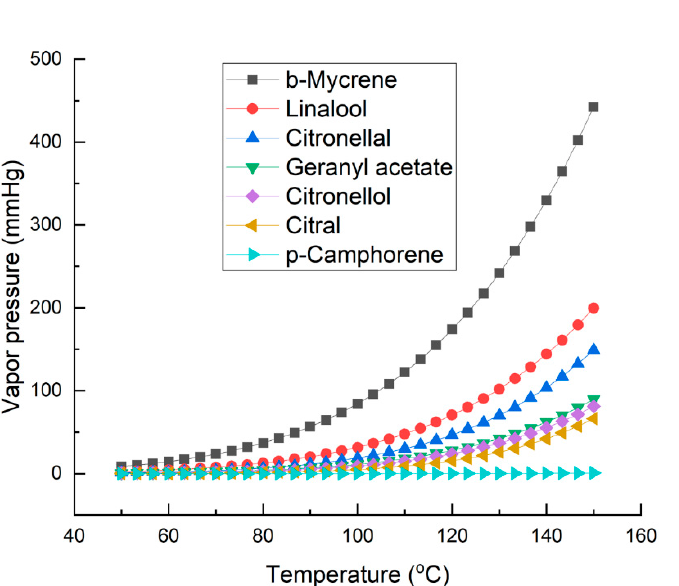
Figure 1. Temperature/pressure graph of the main components of lemongrass essential oil (simu- tion by Aspen Plus lation by Aspen Plus V11).